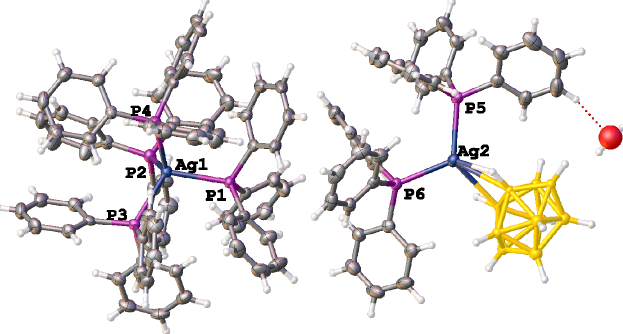
Figure 3. Molecular view of complex 5 · 0.1H 2 O in representation of atoms with thermal ellipsoids ( p = 50%). Only one of two positions of the disordered cage anion is depicted. Table 2. Selected geometrical parameters (Å) of coordination polyhedra of 1–5